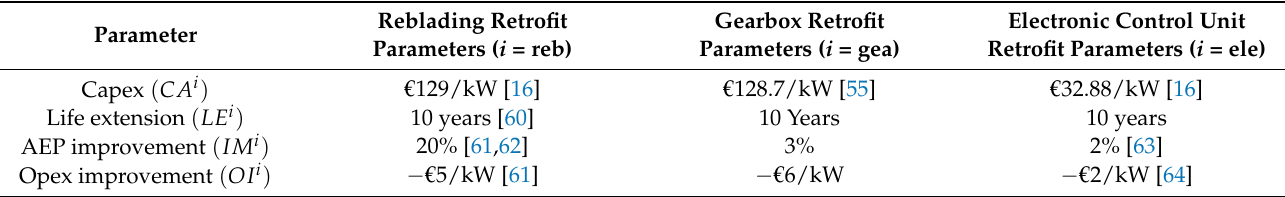
Table 7. Parameters assumed for each life-extension